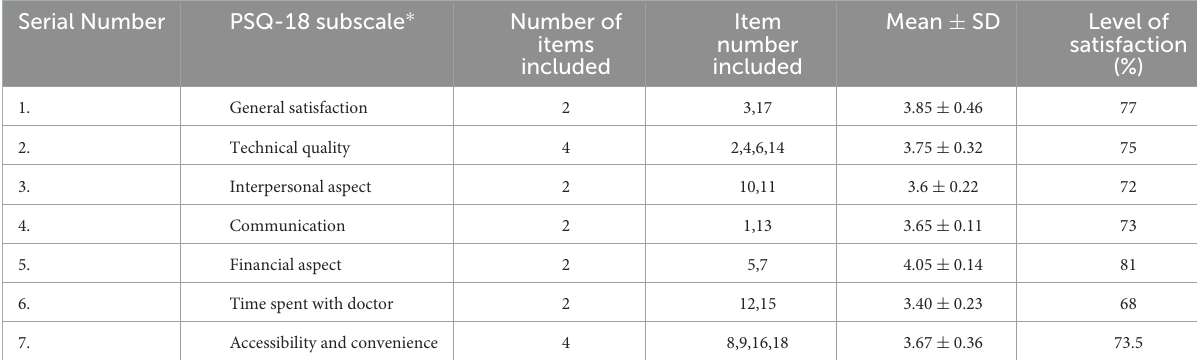
TABLE 2 Description of the PSQ-18 in different subscales.